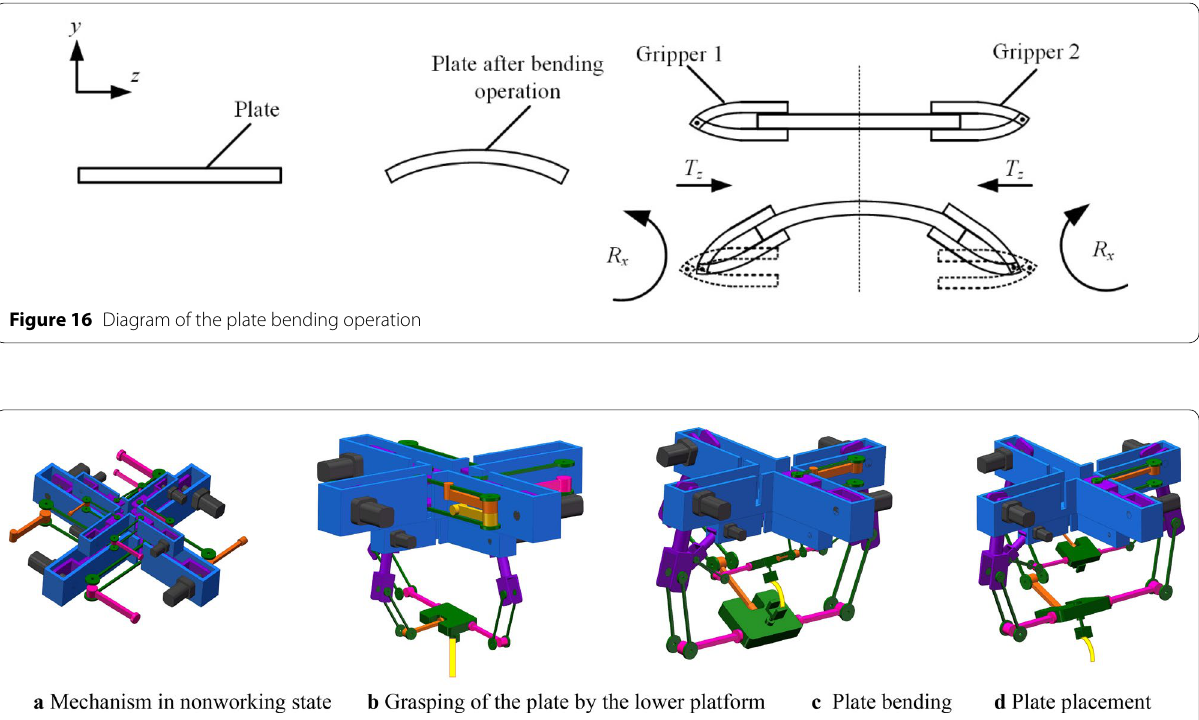
objectReleasable joint Connect to